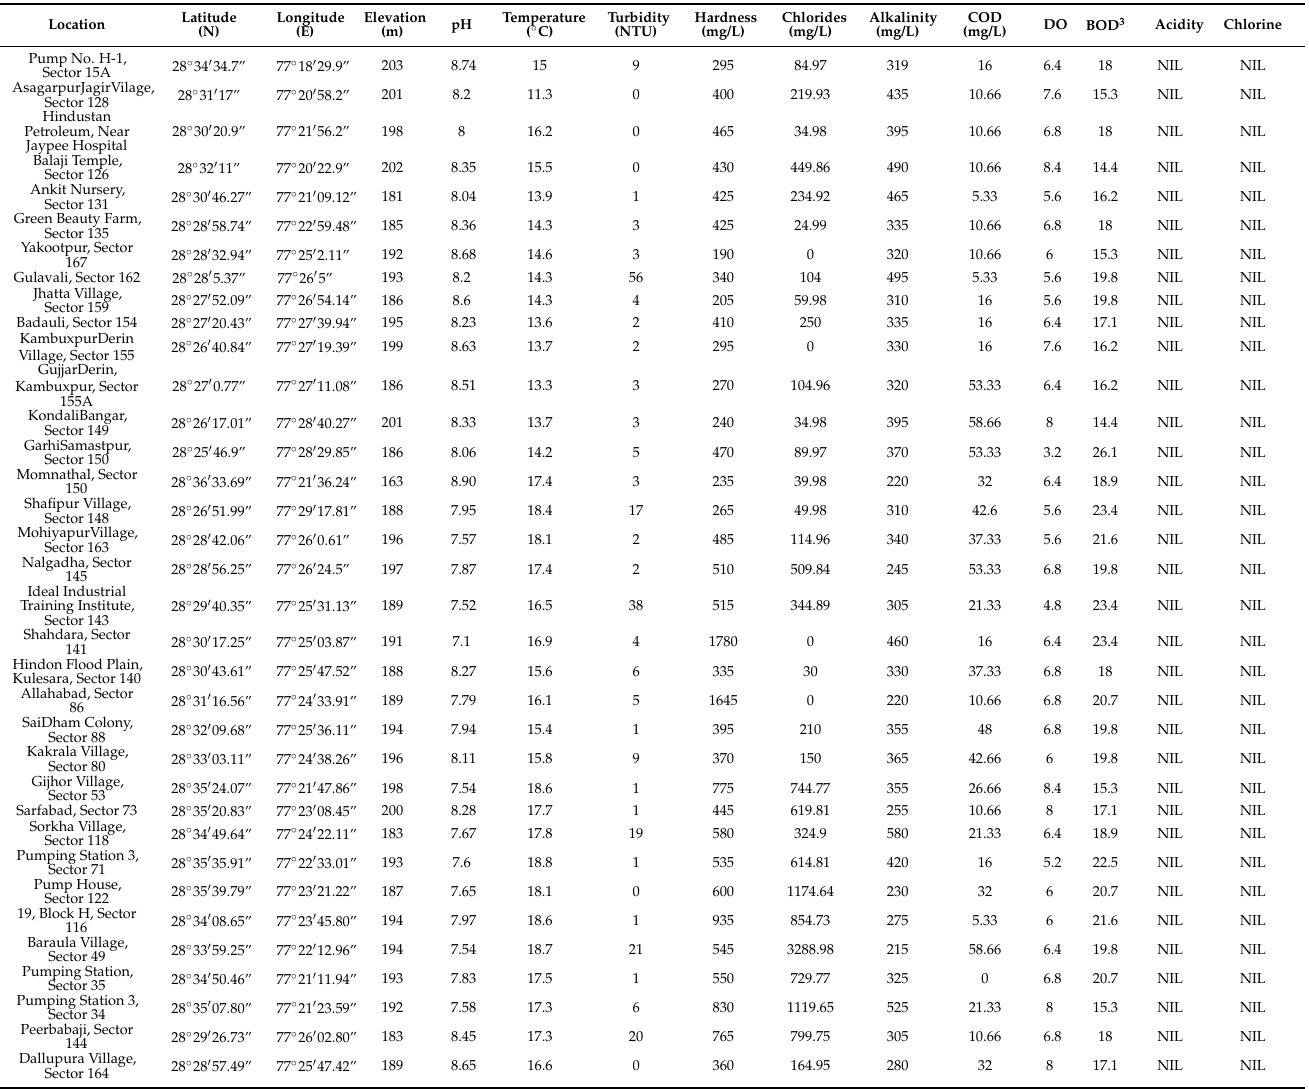
Table 1. Dataset of the study and testing results of water samples collected from different locations of